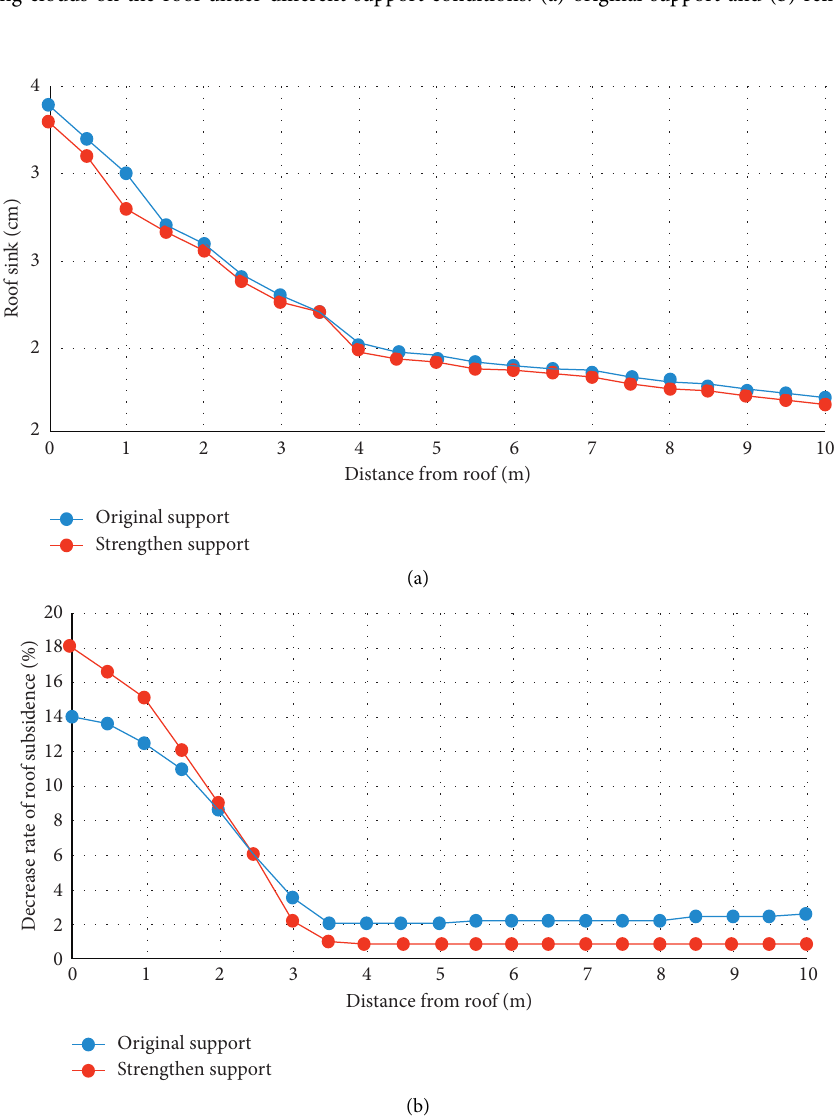
Figure 8: Curve of roof subsidence and reduction rate under different support conditions. (a) Graph of roof subsidence and (b) Graph of a reduction rate of roof